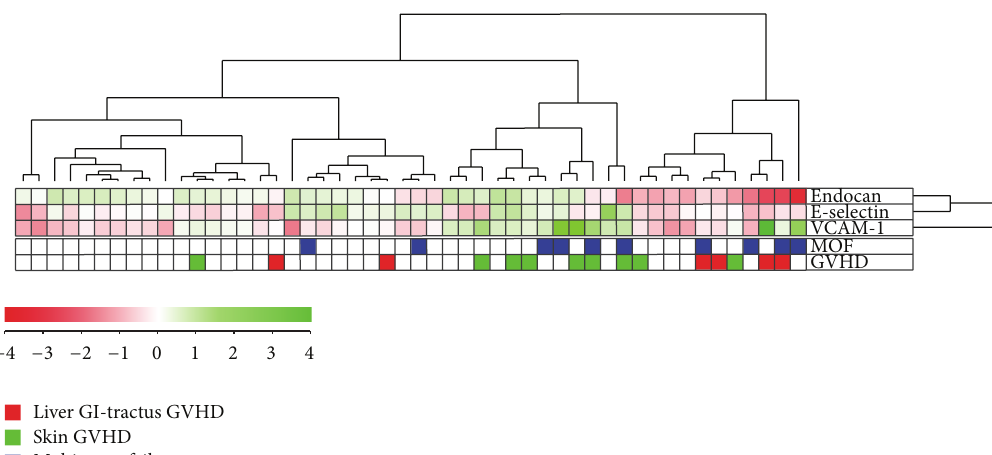
Figure 2: Differences in the serum profile of soluble adhesion molecules derived from endothelial cells (endocan, E-selectin, and VCAM-1) are associated with the frequency of posttransplant acute GVHD. Serum levels of all three endothelium-derived soluble adhesion molecules were determined for 50 consecutive/unselected patients (only those patients where the levels of all three mediators were available) prior to pretransplant conditioning therapy. An unsupervised hierarchical cluster analysis was performed and two major patient subsets were then identified, that is, the right 23 and the left 27 patients. The observation of acute GVHD is indicated in the right part of the figure; green squares indicate skin GVHD alone and red squares indicate that the patients had gastrointestinal or liver affection eventually in combination with skin GVHD. Early (i.e., within 4 weeks of posttransplant) nonrelapse death due to multiorgan failure (MOF) or early acute GVHD grade 4 with later death due to multiorgan failure is also indicated in the figure.